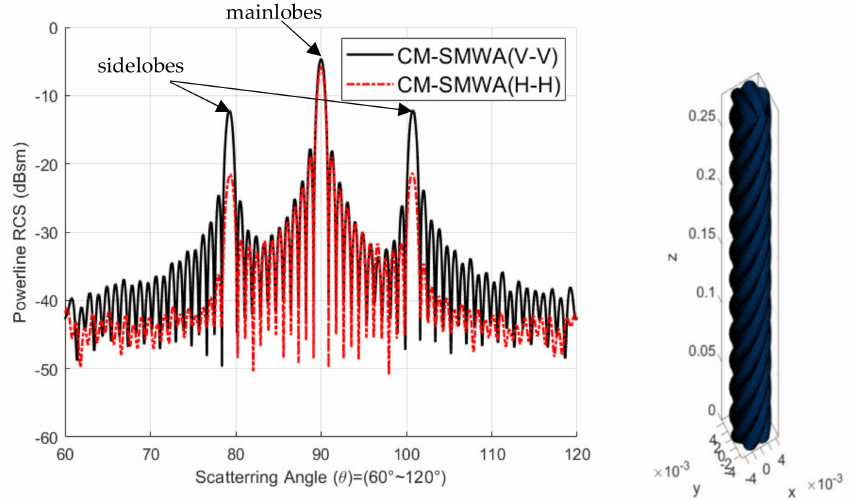
Figure 12. Simulation results of the H-H polarization vs. V-V polarization at 35